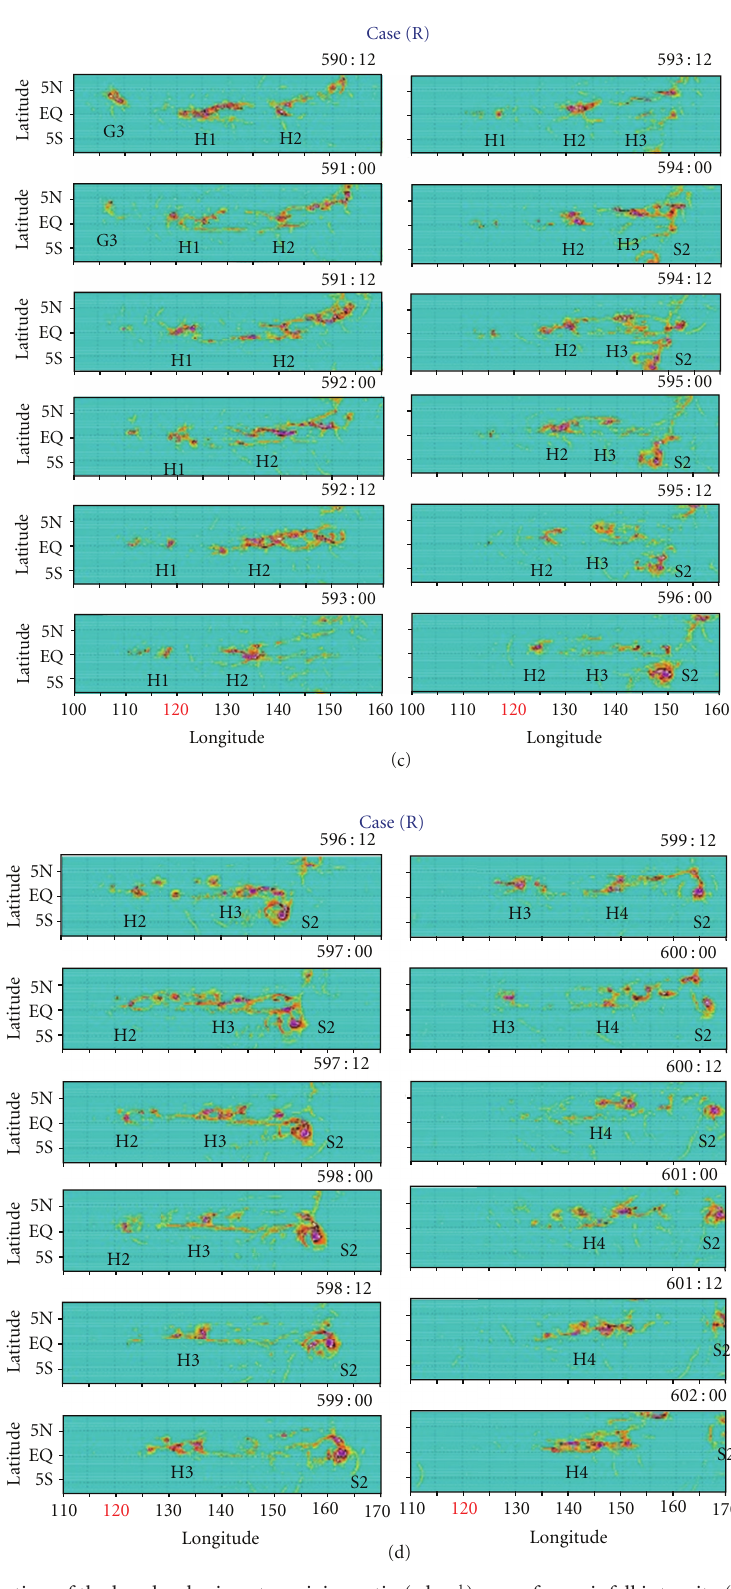
Figure 8: Horizontal distribution of the low-level rainwater mixing ratio (gkg − 1 ) or surface rainfall intensity (mmh − 1 ) in case (R) at a time interval of 12 hours: (a) from 578 day 12 hour to 584 day 00hour, (b) 584 day 12 hour–590 day 00 hour, (c) 590 day 12 hour–596 day 00 hour, and (d) 596 day 12 hour–602 day 00 hour. Each of cloud clusters, which constitute the synoptic-scale convective system, is labeled by F4, G1, G2, ... , and H4. Squall line clusters are labeled by S1 and S2. The ordinate ranges from 8S to